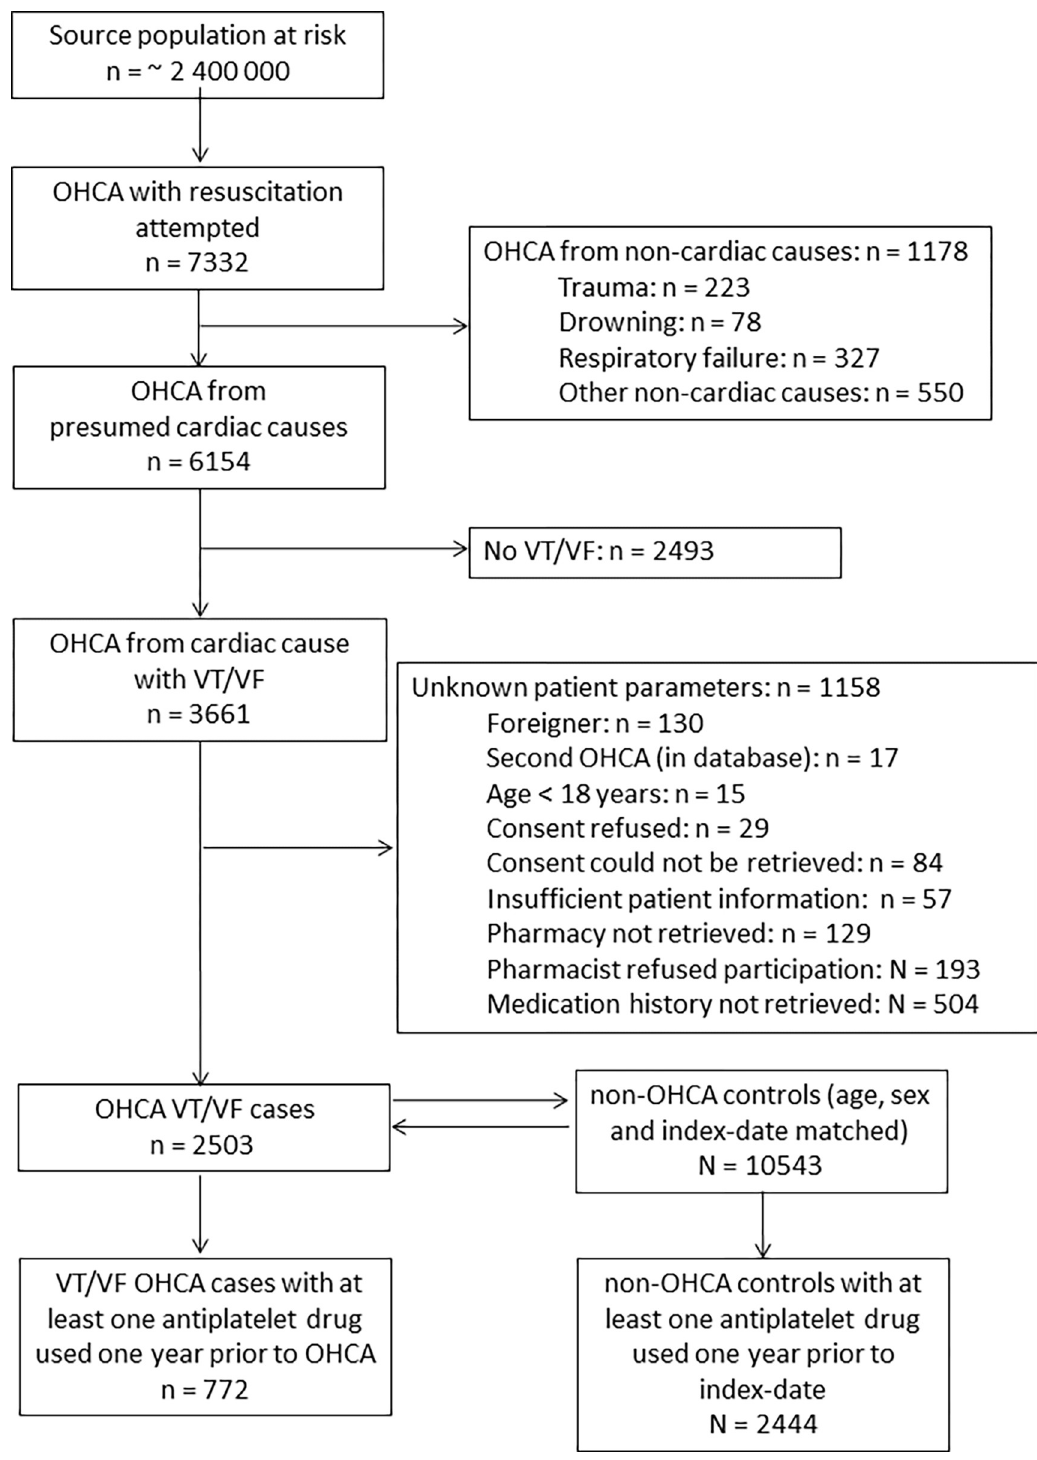
Fig 1. Flow chart of inclusion of out-of-hospital cardiac arrest cases. Abbreviations: OHCA, out-of-hospital cardiac arrest; VT/ VF, ventricular tachycardia/ventricular fibrillation.